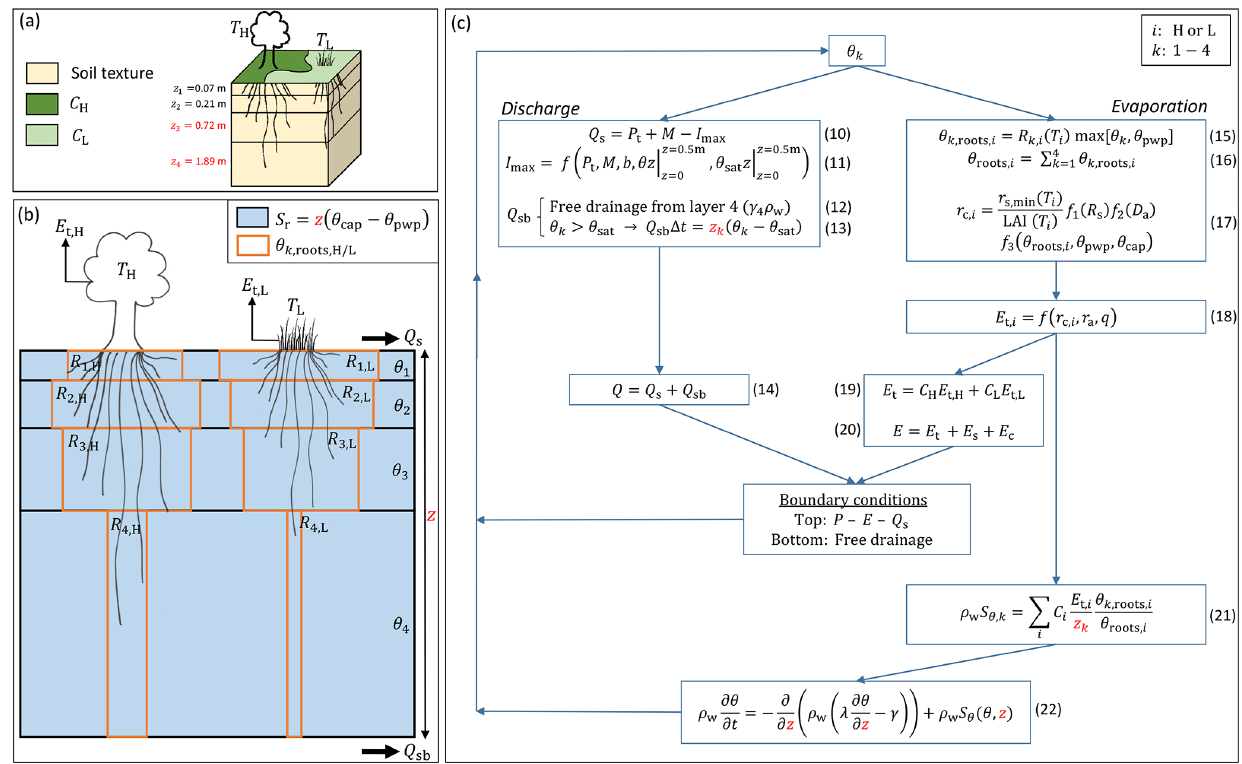
Figure 4. Root zone parameterization in the HTESSEL CTR version with the directly changed parameters in the HTESSEL MD version highlighted in red. (a) 3D overview of a single grid cell. (b) Schematic image of the four-layer subsurface. (c) Scheme of equations for the calculation of soil moisture, discharge and evaporation. The symbols in this figure are as follows, with i representing high (H) and low (L) vegetation and k layers 1–4: C ( − ) vegetation coverage, T dominant vegetation type, z (m) layer depth, P (ms − 1 ) precipitation, P t (ms − 1 ) precipitation through-fall, M (ms − 1 ) snowmelt, Q (ms − 1 ) total discharge, Q s (ms − 1 ) surface runoff, Q sb (ms − 1 ) subsurface runoff, I max (ms − 1 ) maximum infiltration rate, b ( − ) variable representing sub-grid orography, E (ms − 1 ) total evaporation, E t (ms − 1 ) transpiration, E s (ms − 1 ) soil evaporation, E c (ms − 1 ) canopy evaporation, R (%) root distribution, θ (m 3 m − 3 ) unfrozen soil moisture, θ pwp (m 3 m − 3 ) soil moisture at permanent wilting point, θ cap (m 3 m − 3 ) soil moisture at field capacity, θ sat (m 3 m − 3 ) soil moisture at saturation, S r (m) the root zone storage capacity, θ roots (m 3 m − 3 ) the root extraction efficiency, r c (sm − 1 ) canopy resistance, r a (sm − 1 ) atmospheric resistance, R s (Wm − 2 ) downward shortwave radiation, D a (hPa) atmospheric water vapor deficit, q specific humidity (kgkg − 1 ), r s,min (sm − 1 ) minimum canopy resistance, LAI ( − ) leaf area index, S θ (m 3 m − 3 s − 1 ) root extraction rate, γ (ms − 1 ) hydraulic conductivity, λ (m 2 s − 1 ) hydraulic diffusivity and ρ w (kgm − 3 ) density of